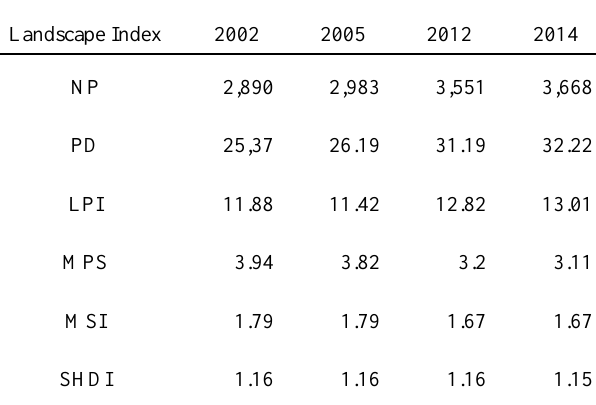
Table 5. Statistics the landscape index of this study area.